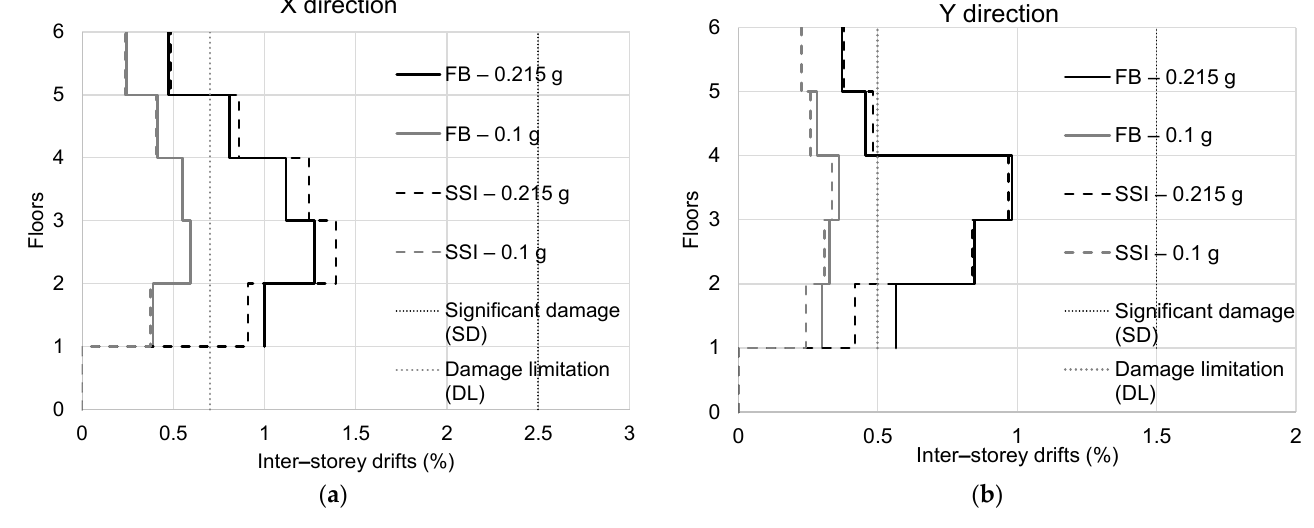
Figure 14. Inter-story drifts: ( a ) X-direction, ( b ) Y-direction. In the observed case, the level of inter-story drift is lower on the ground floor for the